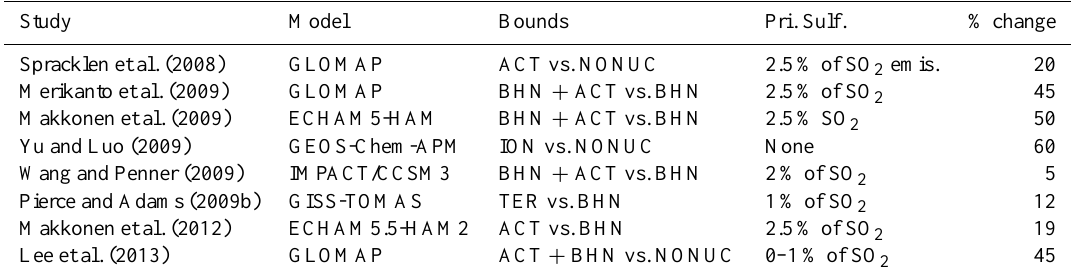
Table 1. Summary of previous nucleation-CCN formation studies. Values are CCN(0.2%) except for Yu and Luo (2009) which used